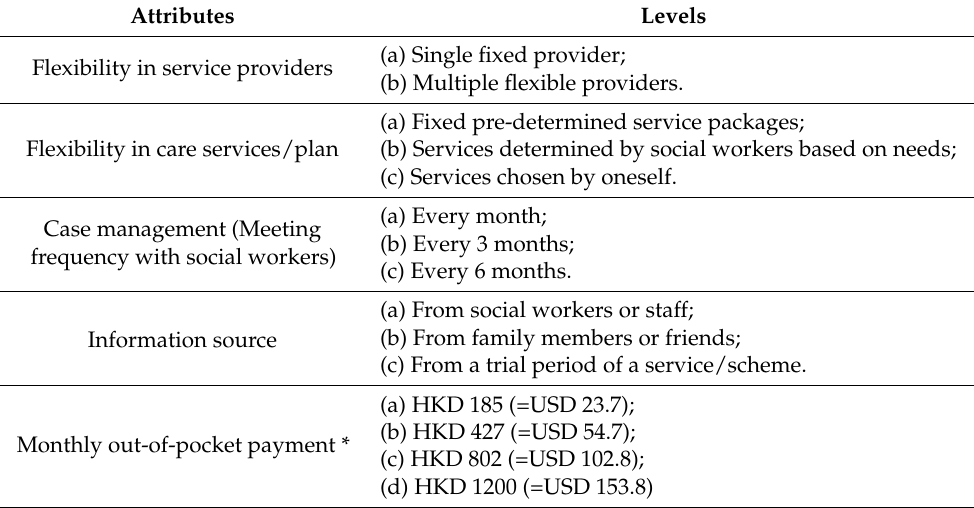
Table 1. The attributes and levels of “money-following-users” for DCE. Attributes Levels Flexibility in service